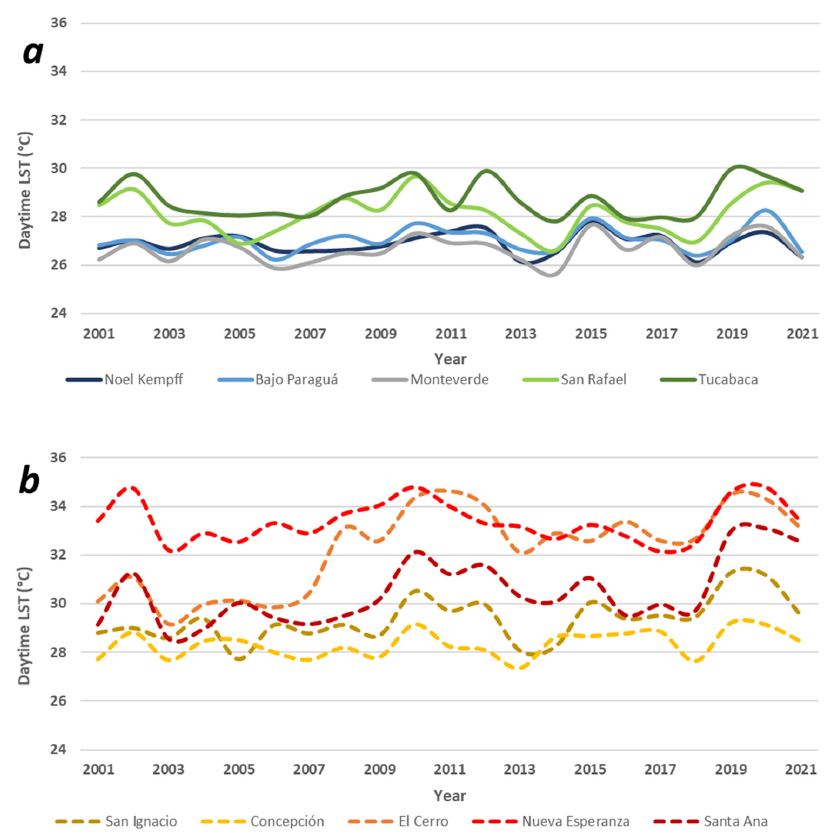
Figure 5. Average annual daytime LST (°C) in forested areas ( a ) and deforested ( b ) areas in the Chiquitania region Chiquitania region (2001–2021).